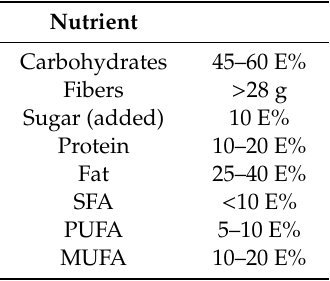
Table 1. Meal plans